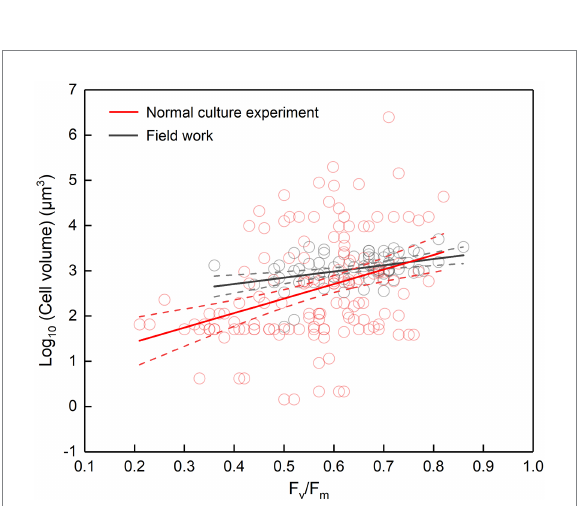
FIGURE 2 F v / F m versus cell volume. Cell volume is either the cell volume of certain species in the normal culture experiment (including the collected data) or the mean cell volume of phytoplankton assemblage in the field work. The regression for normal culture experiment: y = 3.21 x + 0.77, adjusted r 2 = 0.12, p < 0.001; the regression for field work: y = 1.38 x + 2.15, adjusted r 2 = 0.15, p < 0.001; the dotted lines represent the 95% confidence